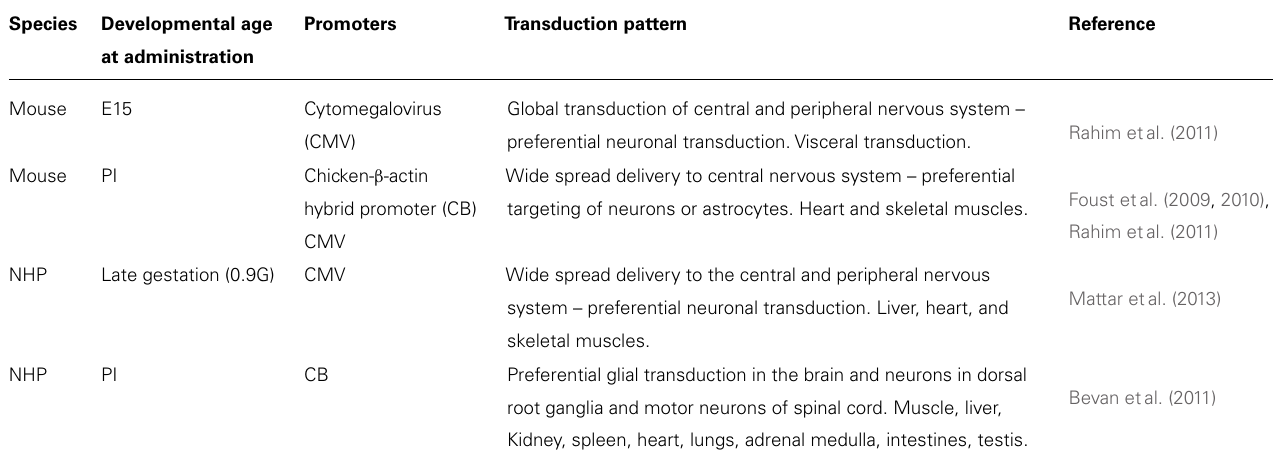
Table 1 | Summary of intravenously administeredAAV9-mediated gene delivery studies in perinatal mice and non-human primates. Species Developmental age at